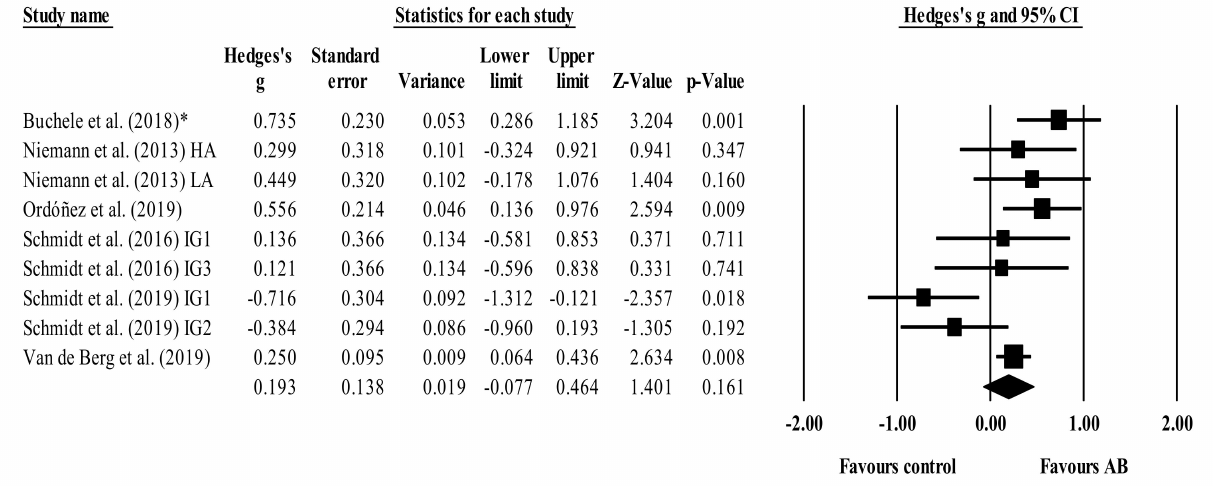
Figure 3. Forest plot of changes in concentration in school-age students participating in active breaks (AB) compared to controls. Values shown are effect sizes (Hedges’ g) with 95% confidence intervals (CI). The size of the plotted squares reflects the statistical weight of each study. The black diamond reflects the overall result. This trend is not statistically significant. IG: intervention group; HA: high-active subgroup; LA: low-active subgroup. * Critical risk in